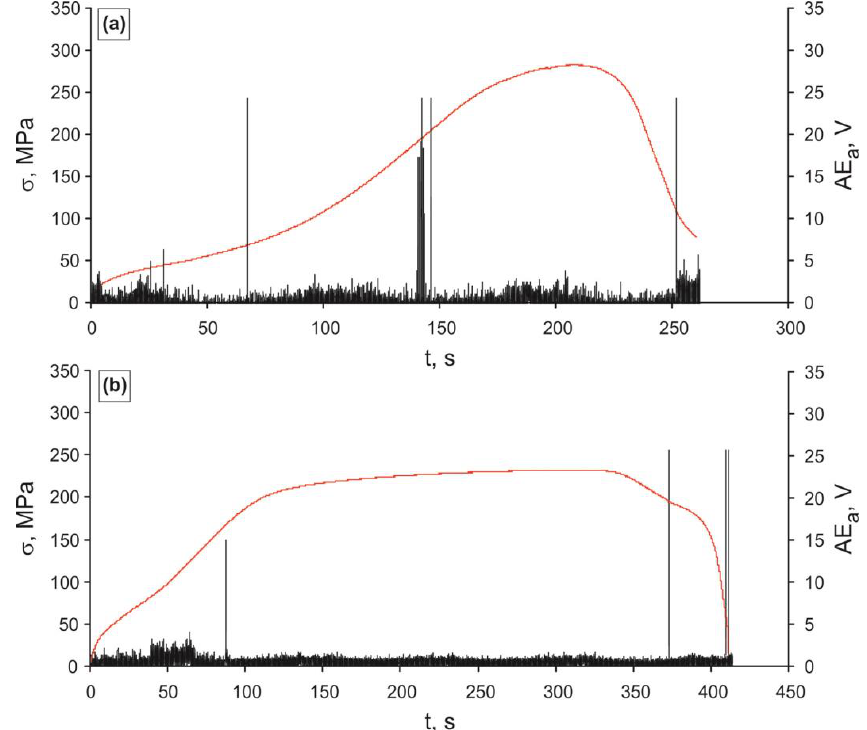
Figure 15. Combined AE diagrams and stress – strain curves for the 5-mm diameter composite sample ( e = 2.77) after annealing at ( а ) 180 °С and ( b ) 300 °С .